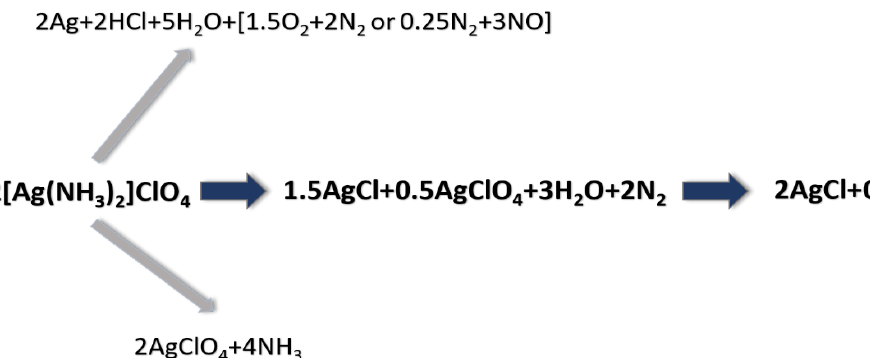
Figure 10. The powder X-ray diffractogram of compound 1 and decomposition intermediate 240 at 300 °C. The composition of I-240 changed during storage in air for 3 days. The XRD of I-240 recorded as a function of time (Figure 11) showed that the peak intensities of silver per- chlorate monohydrate increased, whereas the peak intensities belonging to the anhydrous polymorphs almost completely disappeared with increasing storage time. It means the changes in phase composition can be attributed to the hygroscopic nature of AgClO 4 ; the transformation of the primary decomposition product is fast and decomposes easily into AgClO 4 and AgCl even at 240 °C. However, there are some unassigned XRD peaks of the I-240 intermediate, which belong to a compound that contains coordinated ammonia (see the IR spectrum in Figure S10).